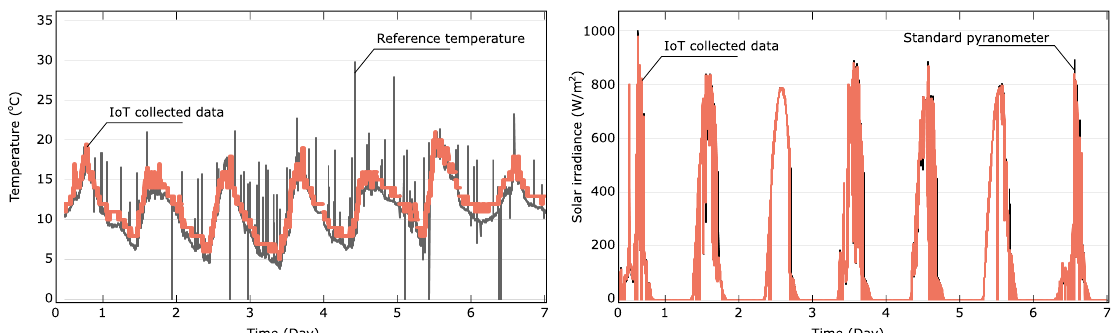
Figure 9. Temperature and solar-irradiance data comparison: low-cost proposed system vs. standard equipment.